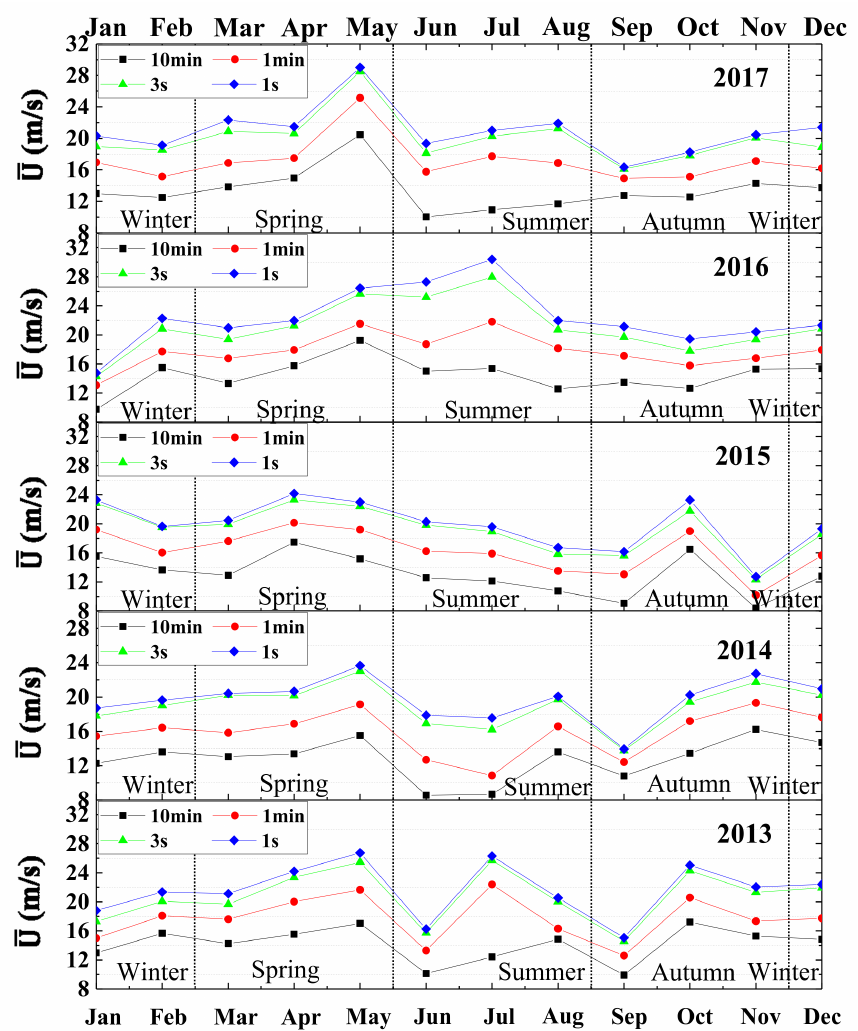
Figure 5. The distribution of the monthly maximum mean wind speeds with different time intervals related to the 140 m anemometer from